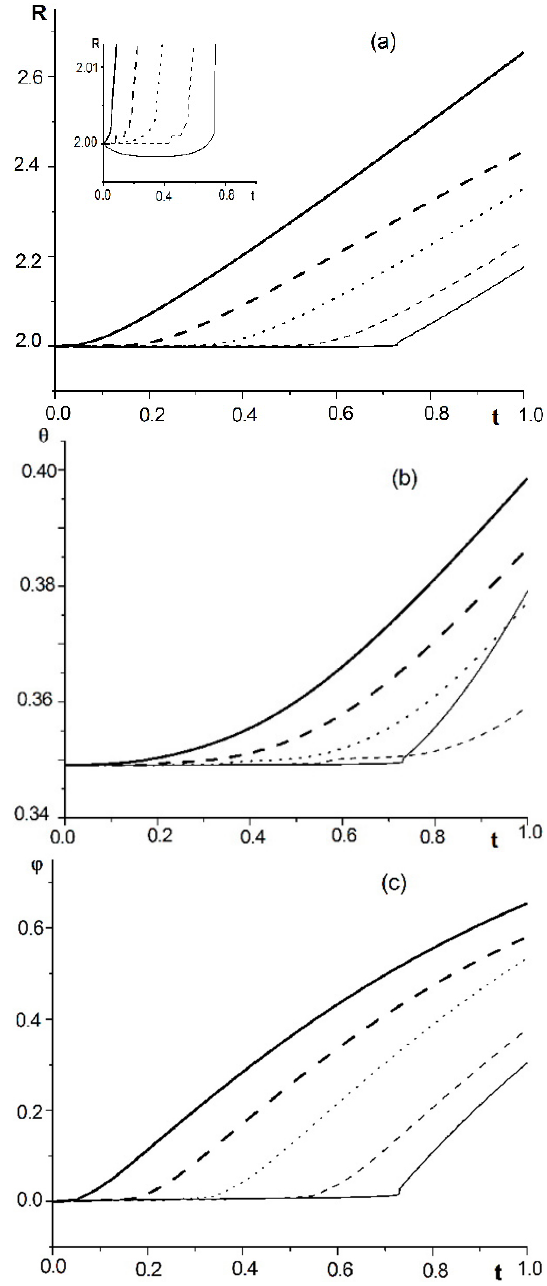
Fig. 1. Spherical coordinates versus time normalized to R E /c for five wave packets with initial wave vector components k θ = 0 , k ϕ = 0 . 75 and different values of k r . Thick solid lines correspond to k r = 0 . 5, light solid lines to k r = − 0 . 5. Thick dashed lines cor- respond to k r = 0 . 25, light dashed lines to k r = − 0 . 25, and dotted lines correspond to k r =